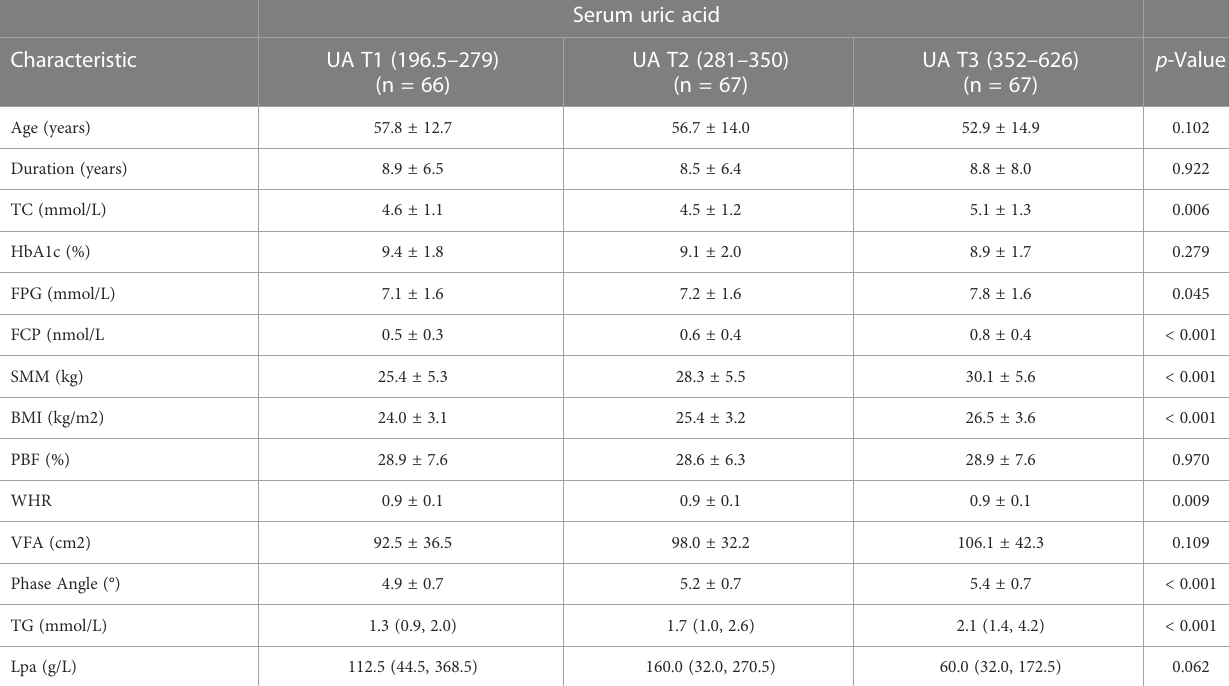
TABLE 1 Clinical characteristics of the study population by serum uric acid